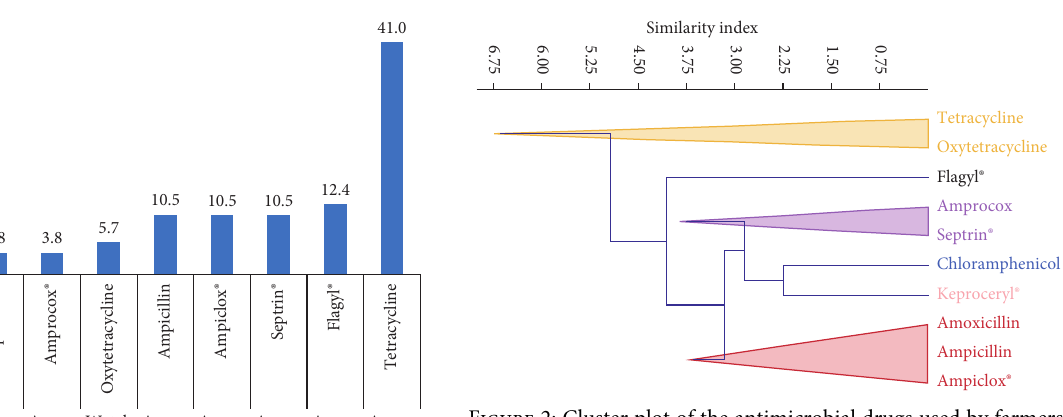
Figure 2: Cluster plot of the antimicrobial drugs used by farmers. Antimicrobials clustered as tetracyclines (tetracycline and oxy- tetracycline), sulfonamides (amprocox ® and septrin ® ), penicillins (amoxicillin, ampicillin and ampiclox ® ), amphenicols chloram- phenicol, and aminoglycosides (Keproceryl ® ).